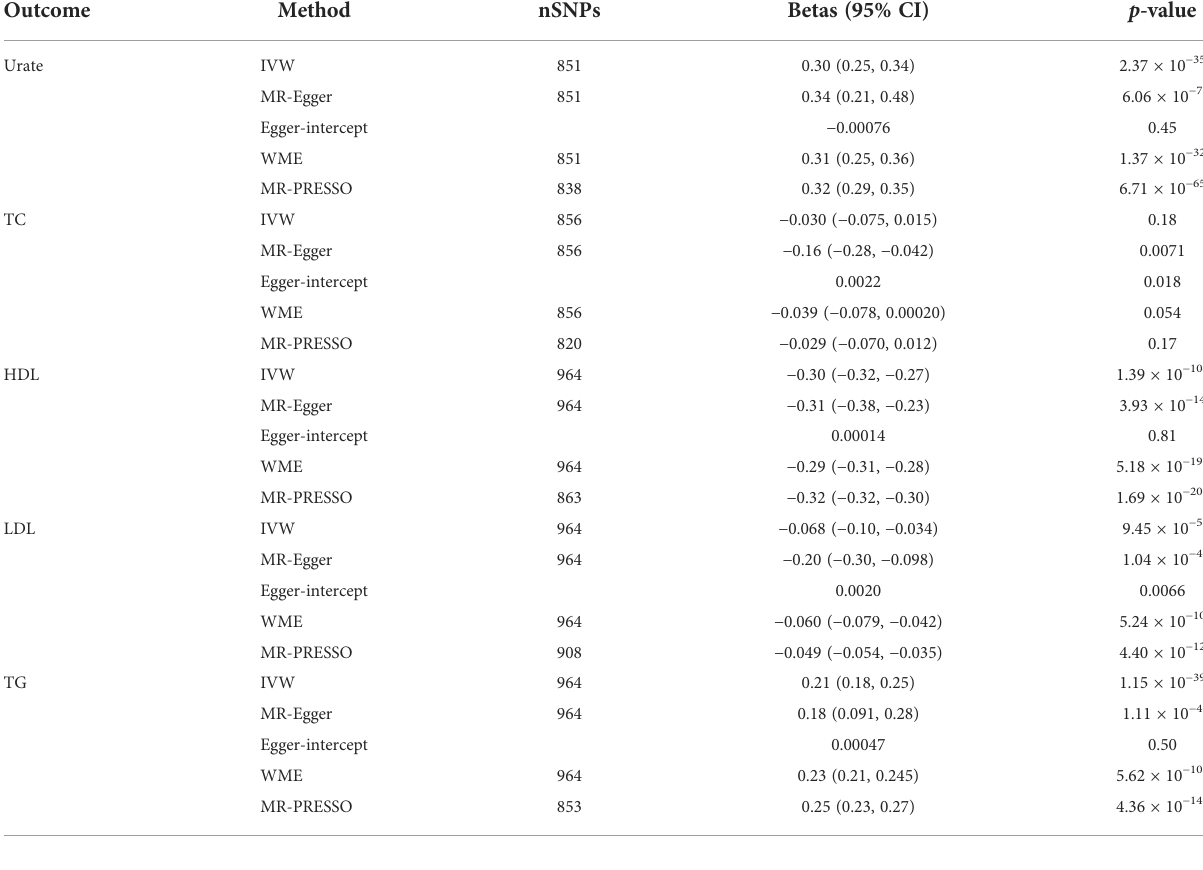
TABLE 4 The effect of BMI on serum urate and lipid traits. Outcome